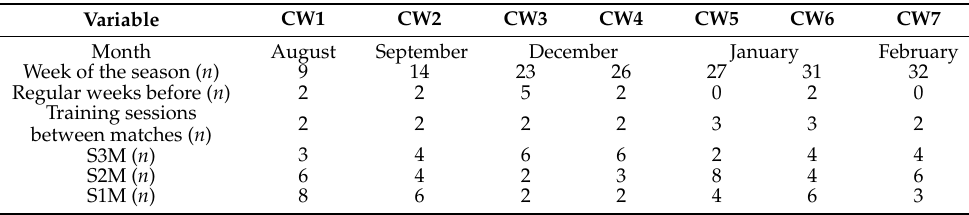
Table 1. Characterization of congested weeks included in this